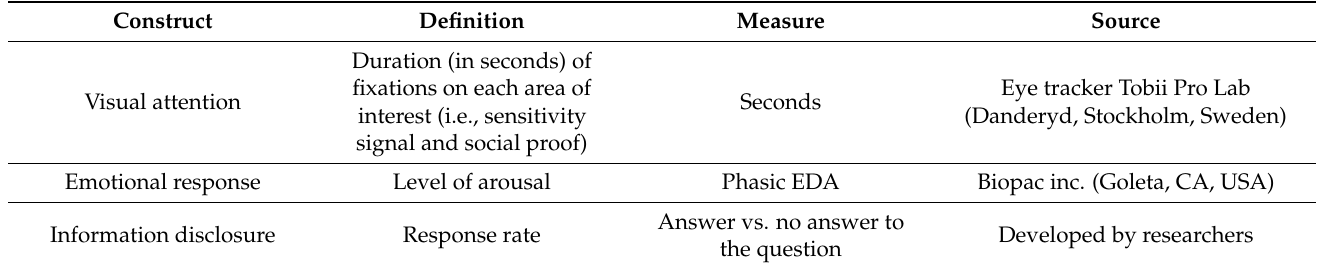
Table 6. Variables